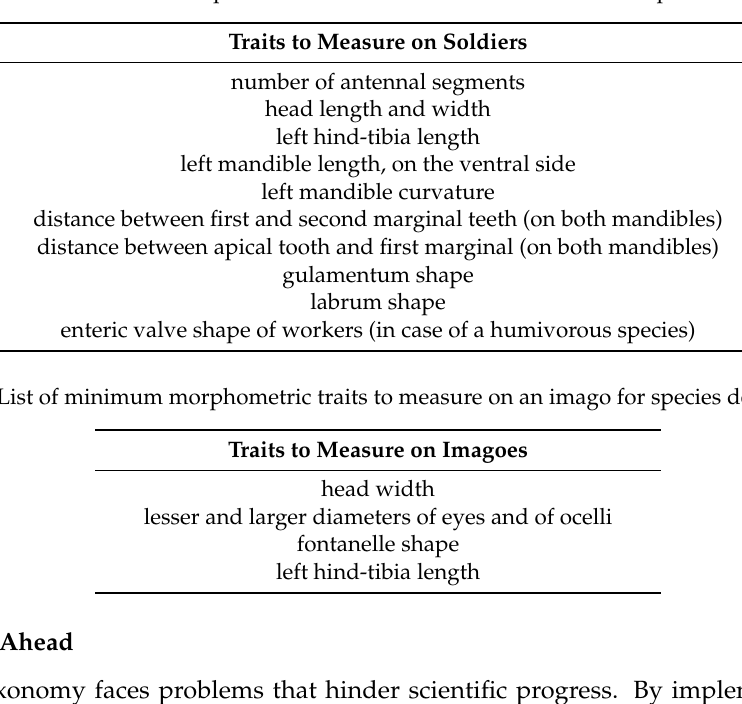
Table 2. List of minimum morphometric traits to measure on a soldier for species description. Traits to Measure on Soldiers